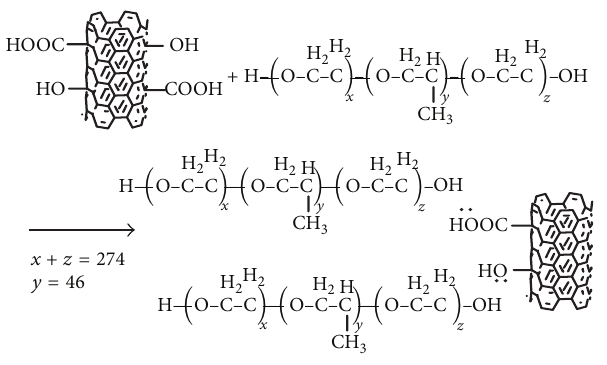
Figure1:Thepreparationprocessofliquid-likeMWNTsnanofluids.